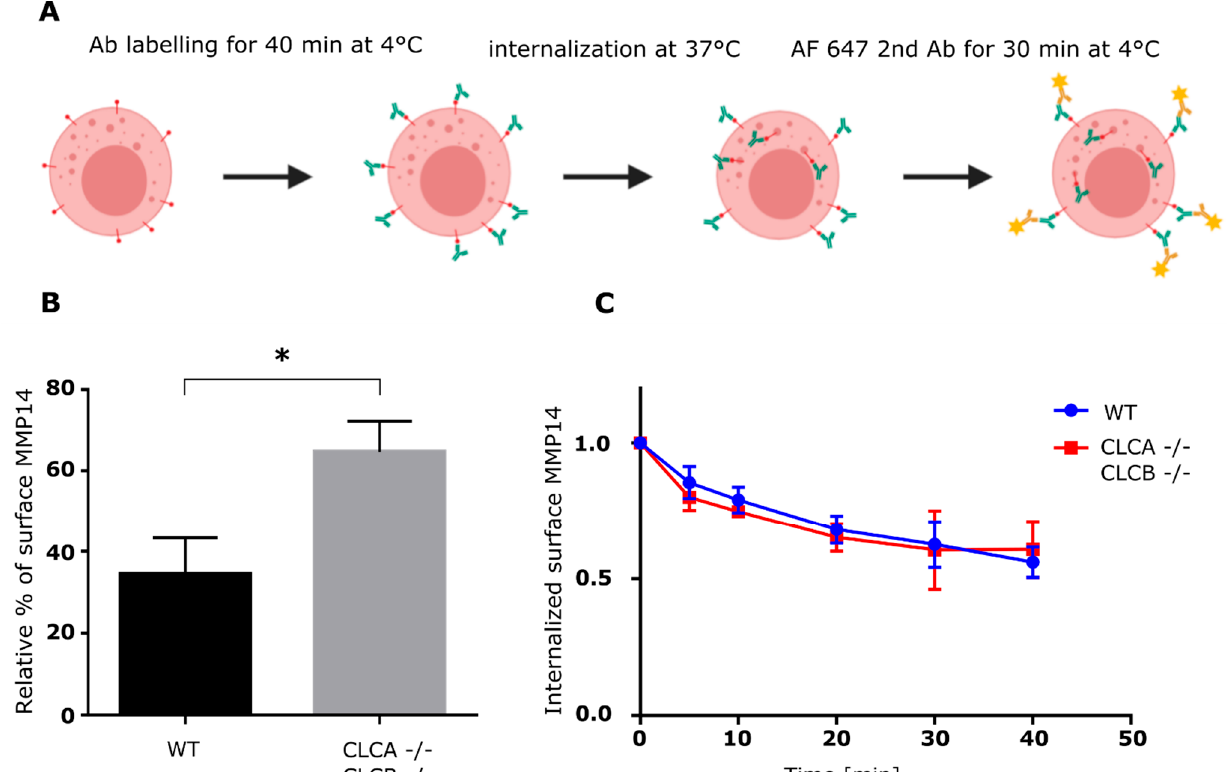
Figure 6. MMP14 expression and internalization in U373 WT and CLCA − / − CLCB − / − cells. ( A ) Schematic of flow cytometry internalization assay. Cells were dissociated from cell culture flasks resuspended in serum free culture medium and kept on ice before incubation with saturating concentration of MMP14 antibody. Internalization was initiated by incubation at 37 °C for the respective time intervals between 0 and 40 min. After MMP14 internalization, cells were incubated with anti-rabbit Alexa Fluor 647 (1:10000) for 30min, washed and analyzed by flow cytometry (FACS Canto II, BD Biosciences). Data were analyzed using FlowJoTM version 10B). ( B ) Surface MMP14 was normalized to total MMP14. Relative percentage was calculated from 3 independent experiments. Median with SD is shown. Statistical analysis: unpaired t test,* p = 0.0111. ( C ) Flow cytometry-based MMP14 internalization assay. Shown are relative MMP14 surface levels normalized to 0 min. Each point represents mean and SD of three biological replicates.